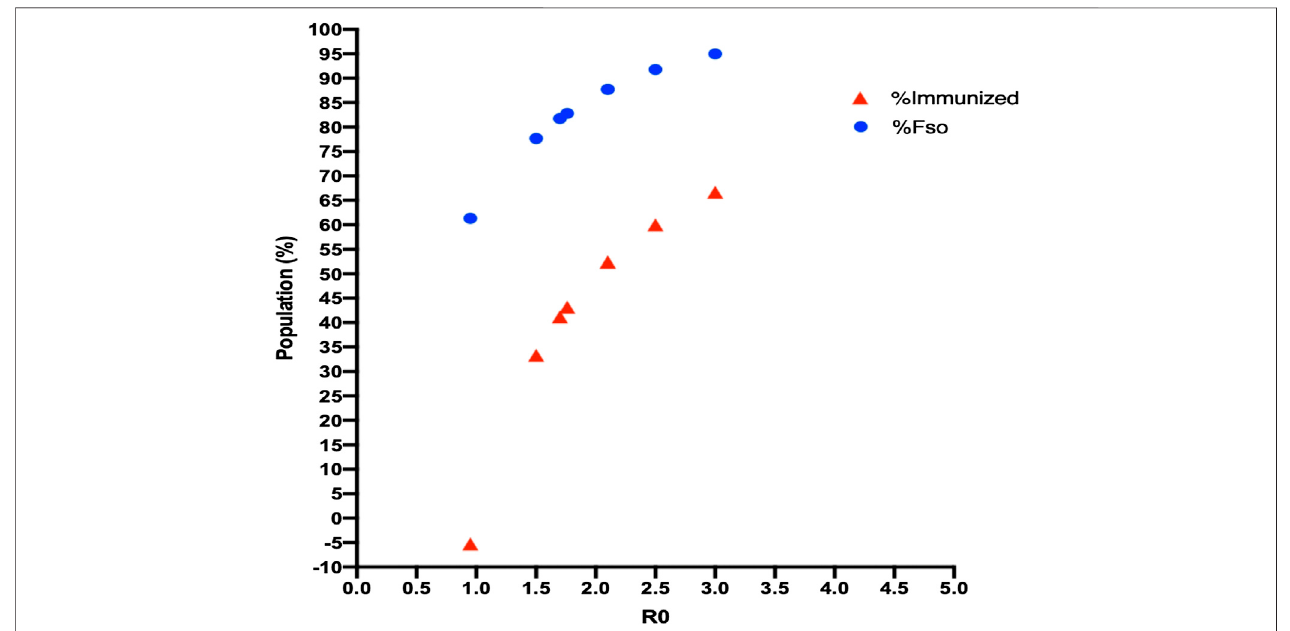
Frontiers in Applied Mathematics and Statistics |